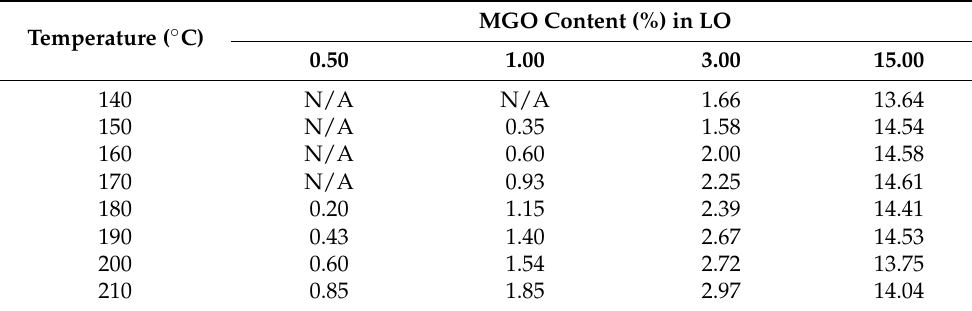
Table 2. Calculation of MGO content in LO using the standard calibration